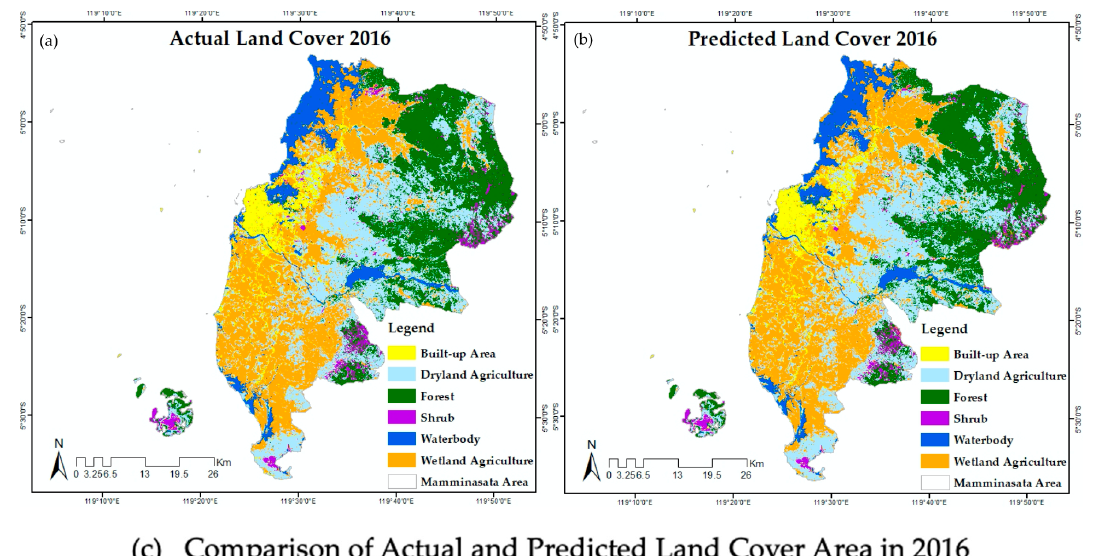
14 of 23 Figure 7. Driving factor maps: ( a ) distance from capital, ( b ) distance from river and lake, ( c ) distance from road, ( d ) distance from settlement, ( e ) elevation, ( f ) slope, and ( g ) population density per pixel. Distances and elevation are in meters, slope is in degrees, and population density per pixel is in people/km 2 . The transition potential was obtained with 33.56% accuracy by running the MLPNN method from a combination of the basic maps (2006 and 2011) and the seven driving factors. This transition potential was used to simulate the land cover prediction for 2016 by using the MC method, and the resulting map is shown in Figure 8b. Table 5. Cramer’s V values of driving factors. Variable